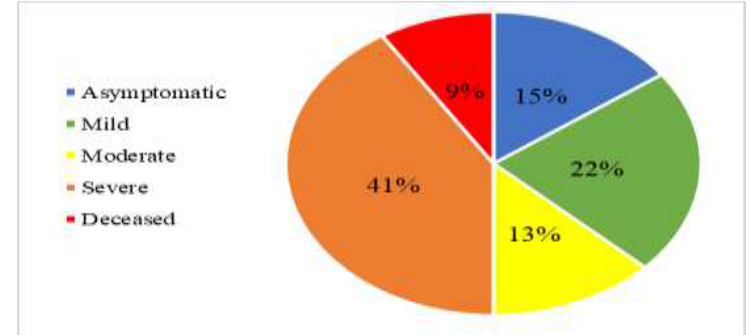
Figure 1: Disease severity distribution in 100 COVID-19 patients.